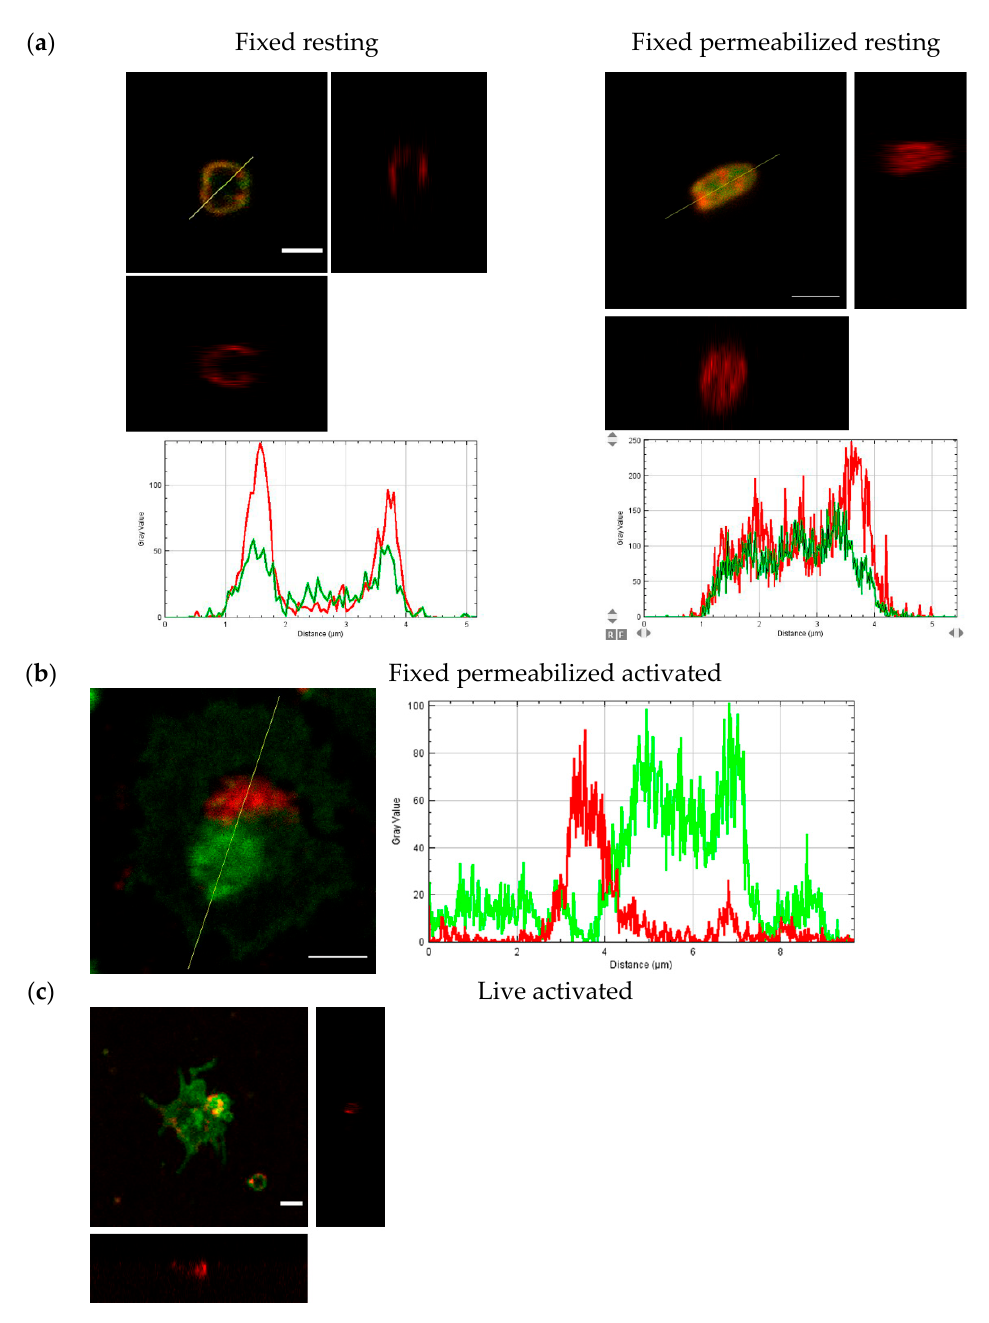
Figure 8. The confocal microscopy images and orthogonal view of Z-stack of resting and activated platelets. CD61—green, T-cadherin—red. Plots of fluorescence intensity along the cross-section line from ( a , b ), respectively. ( a ) Fixed resting human platelets—non-permeabilized (left) and permeabilized (right); ( b ) fixed and permeabilized activated human platelet; ( c ) live activated human platelet. Scale bar (white line) 2 μ m.